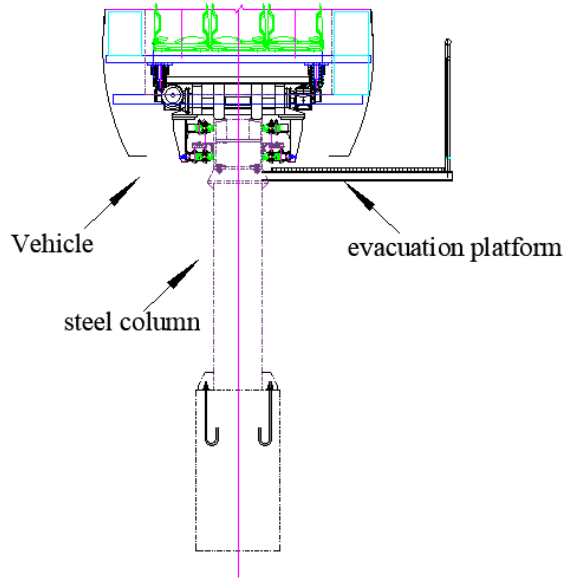
Figure 2. Section form of MTTS.